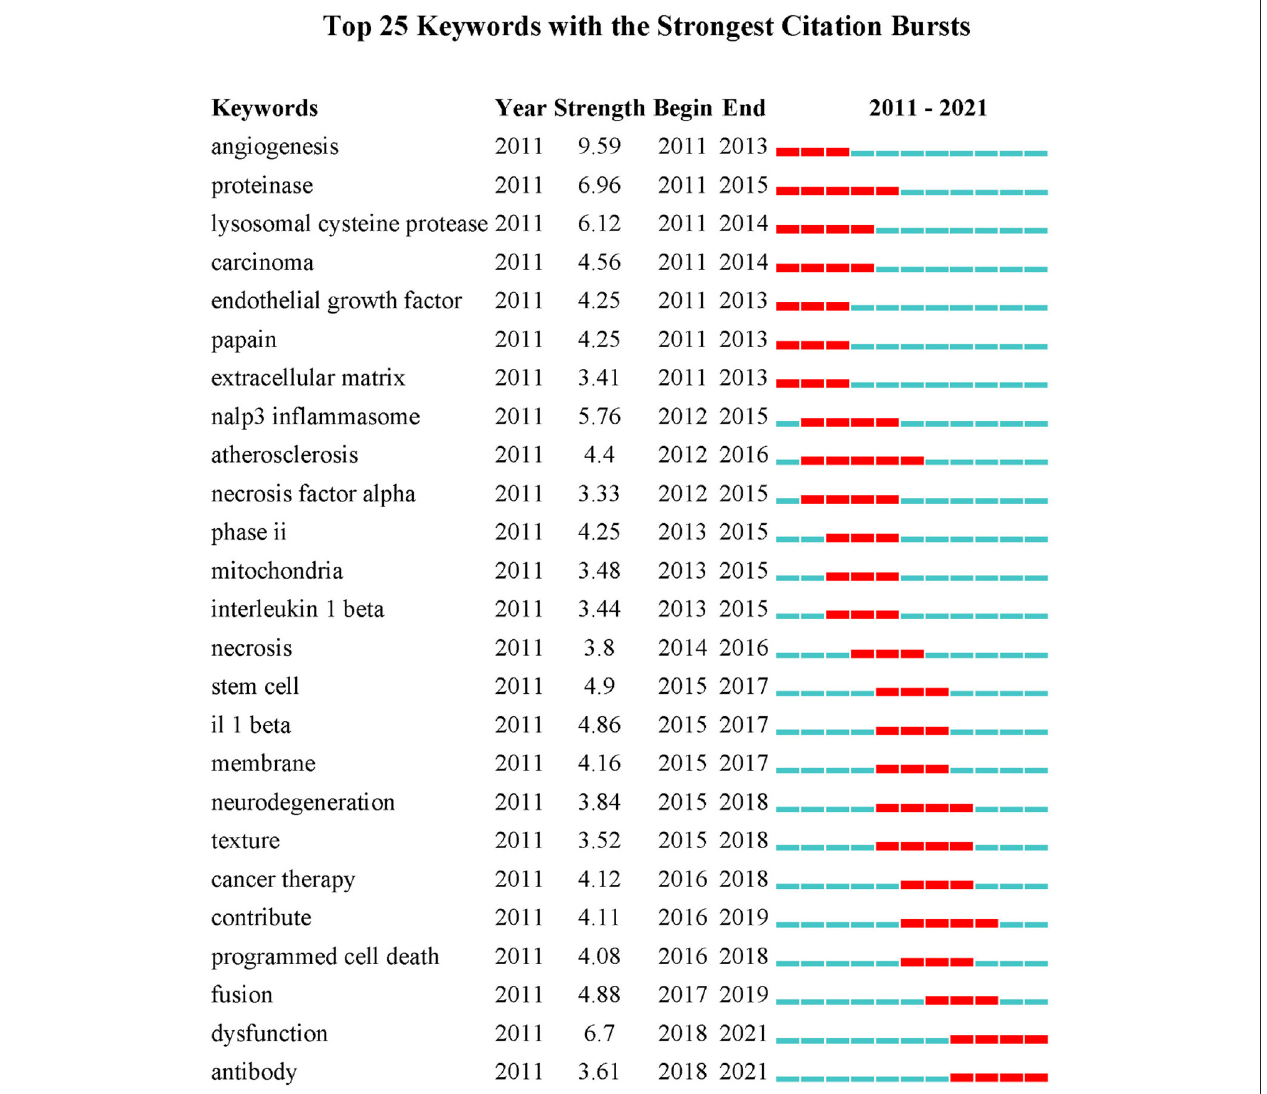
diseases, CTSB-associated cell death pattern, and the applications of